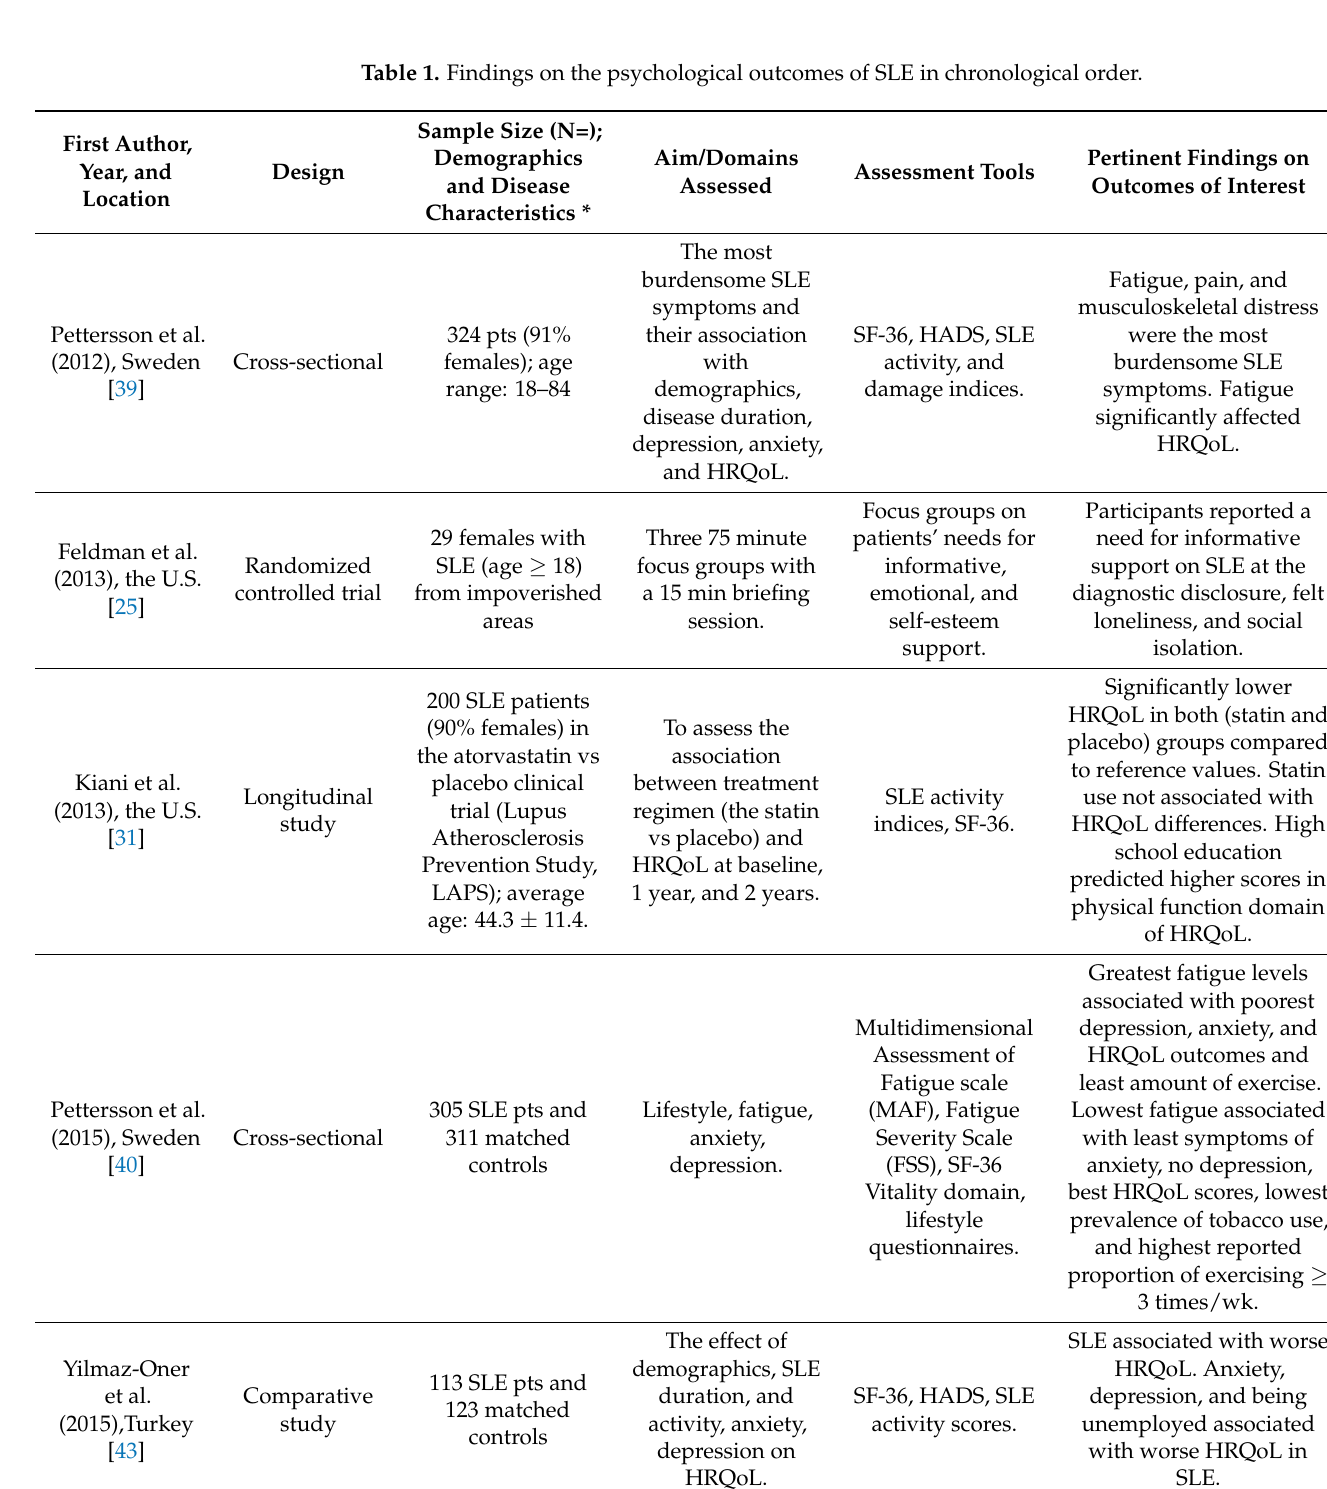
Table 1. Findings on the psychological outcomes of SLE in chronological